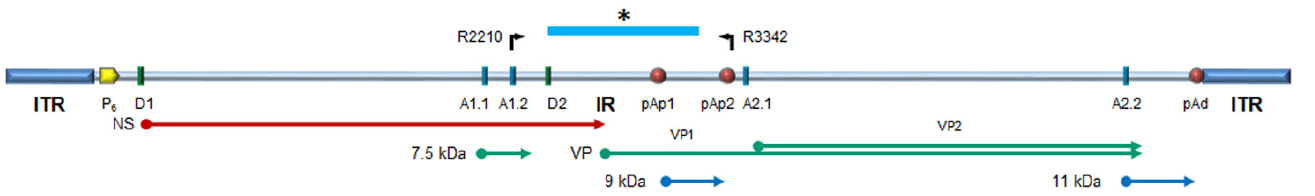
Figure 1. Schematic diagram of B19V genome. ITR, inverted terminal regions; IR, internal region; cis-acting functional sites: P6, promoter; pAp1, pAp2, proximal cleavage-polyadenylation sites; pAd, distal cleavage-polyadenylation site; D1, D2, splice donor sites; A1.1, A1.2, A2.1, A2.2, splice acceptor sites. Top: primer location and genome segment included in NGS analysis (*). Bottom: open reading frames and coding sequences for the viral proteins. NS, non-structural protein NS1; VP, structural proteins, colinear VP1 and VP2, assembled in a T1 icosahedral capsid; 7.5 kDa, 9.0 kDa, 11 kDa: minor non-structural proteins. Modified from [30].